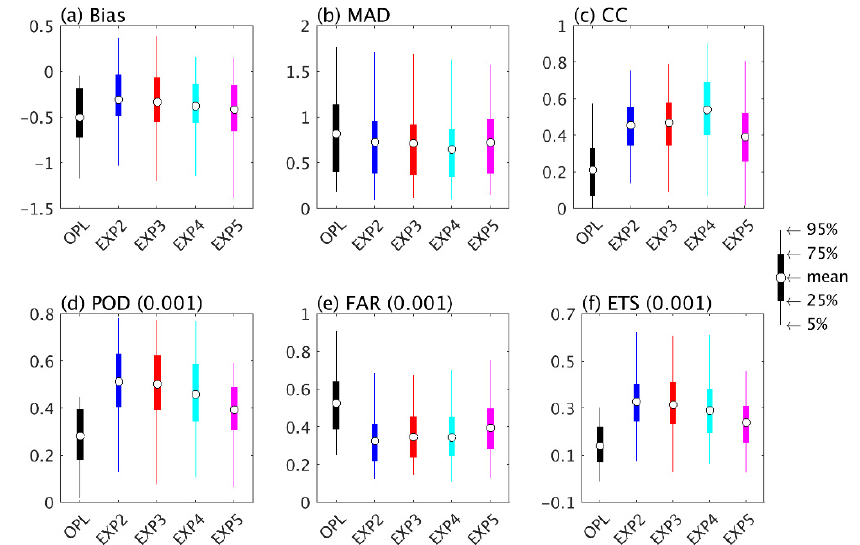
Figure 5. Boxplots of statistical metrics of hourly precipitation estimates estimated from each assimilation experiment and the OPL experiment. The threshold for calculating the POD, FAR, and ETS is 0.001 mm / h, which is the threshold of distinguishing precipitation or no precipitation in the IMERG data. EXP2 and EXP3 represent experiments with nontransformed and logarithmically transformed precipitation with constant observation error, respectively; EXP4 and EXP5 are as for EXP2 and EXP3, but with increasing observation error with precipitation magnitude.